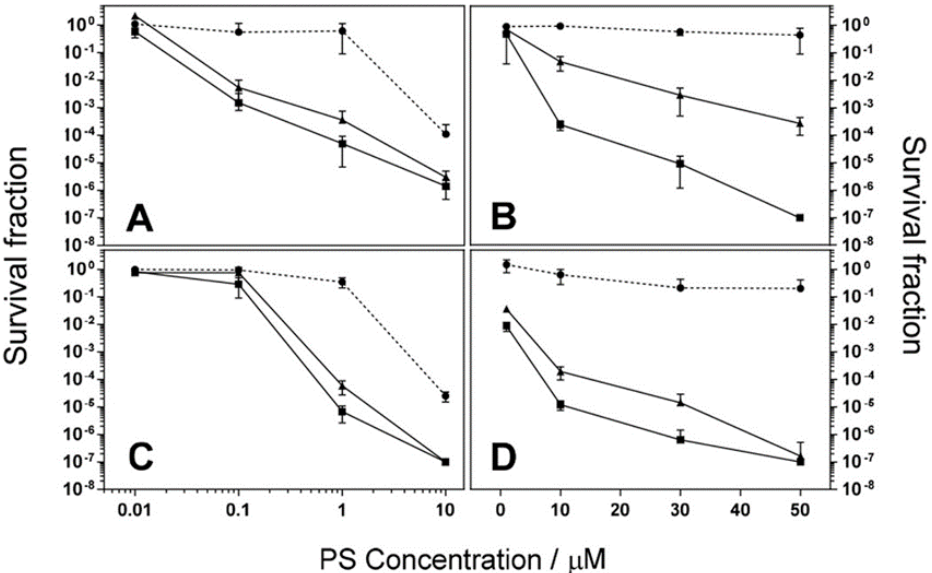
Figure 13. Bacterial survival of S. aureus ( A , C ) and E. coli ( B , D ) after photodynamic inactivation treatment. Compound 54 effects viewed in A and B, and compound 55 viewed in C and D. Circles represent dark toxicity (J·cm −2 ), triangles (J·cm −2 ), and squares (J·cm −2 ). Figure used with permission from [29]. Copyright 2020 Elsevier.